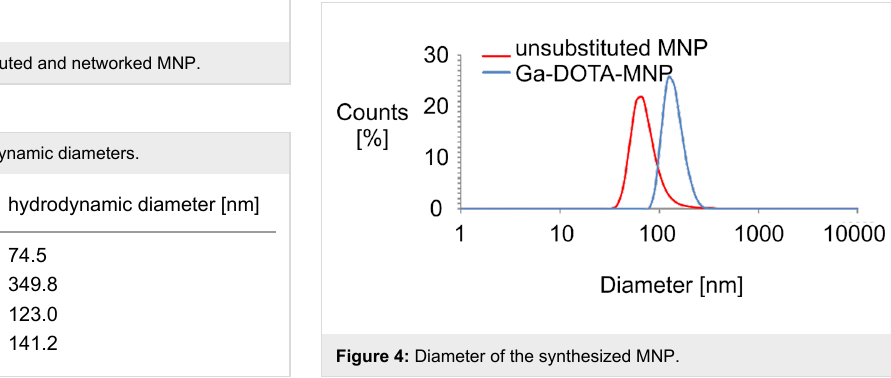
Figure 3: Diameter of the unsubstituted and networked MNP.